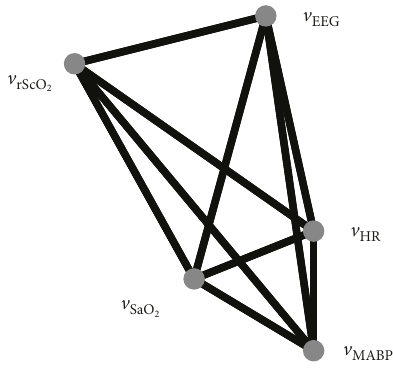
Figure 3: Physiological network representing the interaction between 5 signal modalities recorded on a neonate after propofol administration. The graph consists of 5 vertices, corresponding to the signal modalities. In addition, an edge is present between every pair of nodes (complete graph). Each edge is de fi ned by a weight value that represents the interaction between the corresponding signal